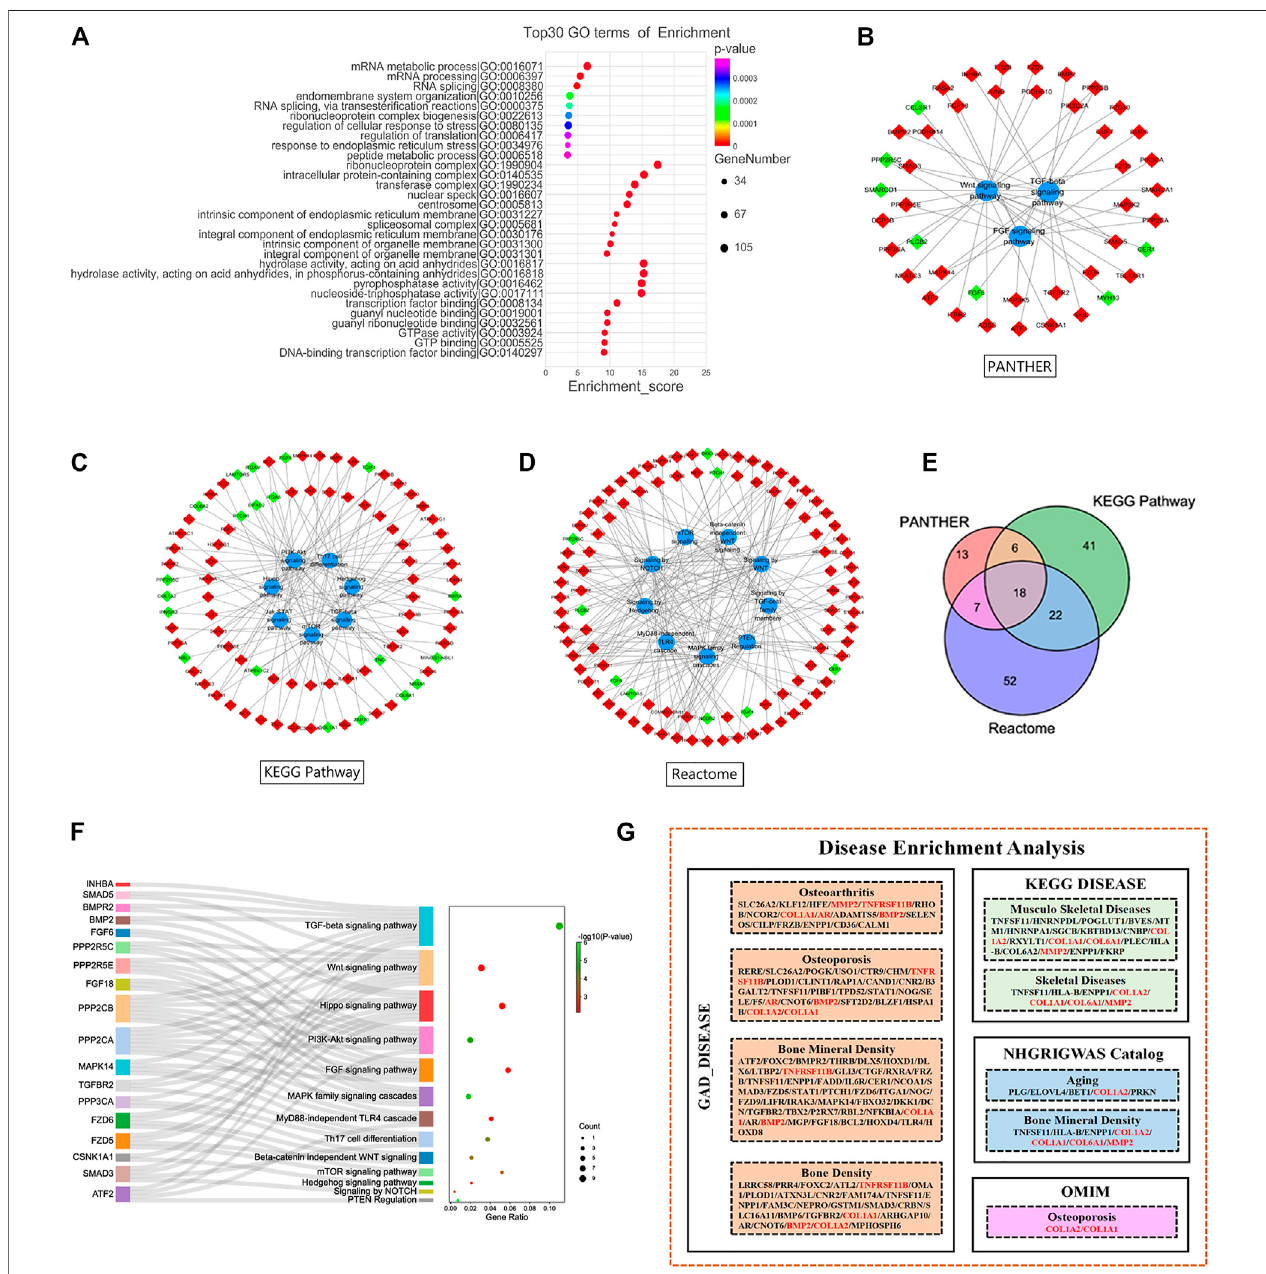
FIGURE3| FunctionalEnrichmentAnalysisofDEmRNAs. (A) GeneOntologyanalysisofallDEmRNAs.PathwayanalysisofPANTHER (B) ,KyotoEncyclopediaof Genes and Genomes Pathway (C) and Reactome Pathway database (D) . (E) Intersection of DE mRNAs from 3 pathway database. (F) Pathways of target DE mRNAs. (G) Disease enrichment analysis of all DE mRNAs. Red and green diamond represented upregulated and downregulated DE mRNAs, respectively. DE, differentially expressed.